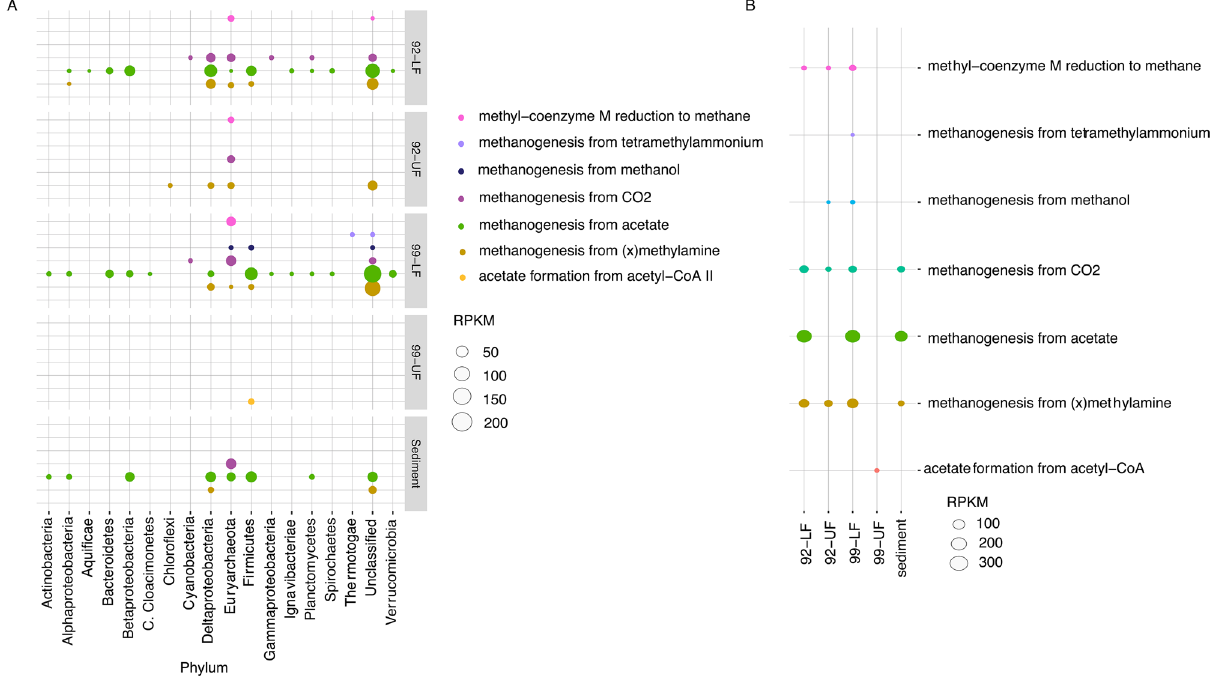
Figure 4. An overview of the methanogenesis pathways. ( A ) Shows the methanogenesis pathway abundances in the phyla. ( B ) Indicates the methanogenesis pathway abundances in each sample. Since only 44% of the reads mapped back to the UF99 sample, not much information can be inferred from the data belonging to this sample. Here, we view methane metabolism from carbon dioxide to be the main pathway present in Euryarchaea (the only known anoxic methanogens). Methanogenesis from acetate is another pathway seen abundantly in non-methanogens. This could indicate acetate as a source of energy in this anoxic